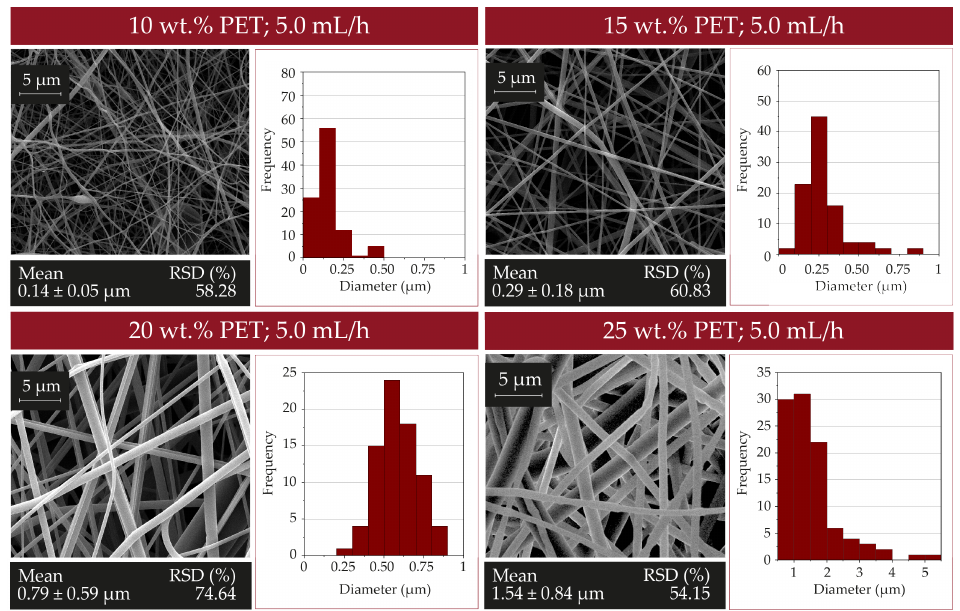
Figure 3. SEM micrographs and fiber size distribution histogram of electrospun fibers ( n = 100) as a function of the polymer concentration (10, 15, 20 and 25 wt.%) in the solution electrospun at 5.0 mL/h flow